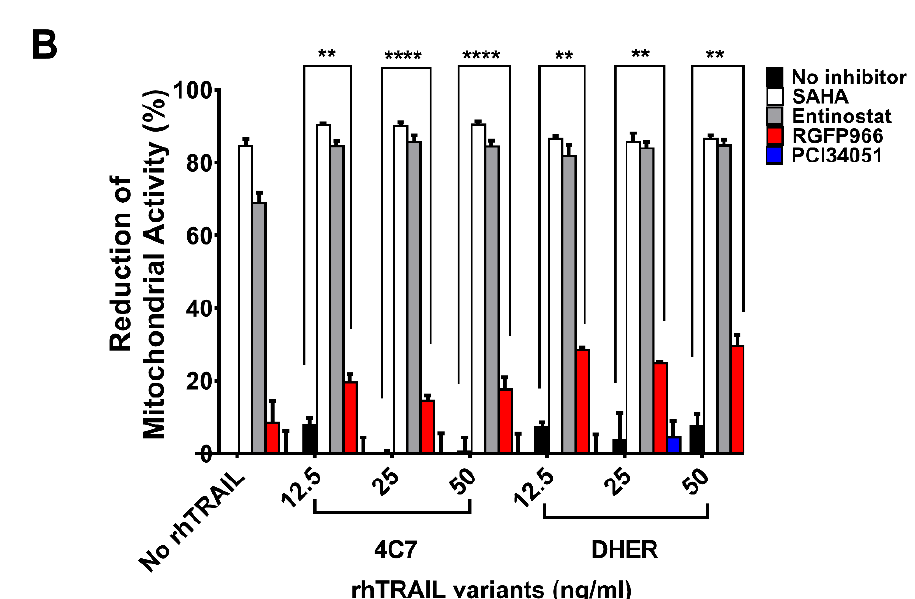
Figure 1. Alterations of cell viability after treatment with HDAC inhibitors and rhTRAIL variants 4C7 or DHER. DLD-1 cells ( A ) or WiDr cells ( B ) were firstly treated with 10 μ M HDAC inhibitors including SAHA, Entinostat, RGFP966, or PCI34051, respectively, for 24 h and the day after cells were incubated with rhTRAIL 4C7 or DHER overnight. Cell viability was determined by MTS assay. The values shown are mean ± SD from one of three experiments performed in triplicate. p values were analyzed by one-way ANOVA in Turkey’s multiple comparison with Graphpad Prism version 7.0. ** 0.001 ≤ p ≤ 0.01, **** p ≤ 0.0001.